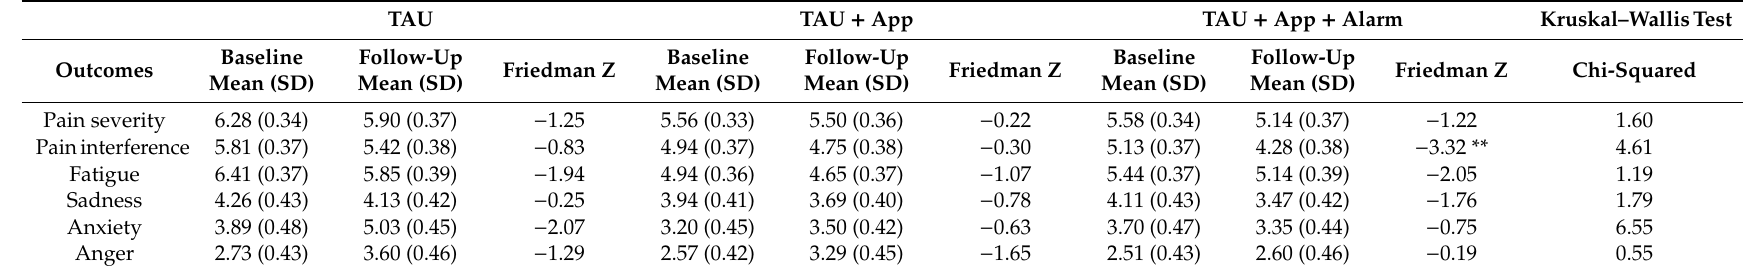
Table 1. Group-level changes in study outcomes across conditions.